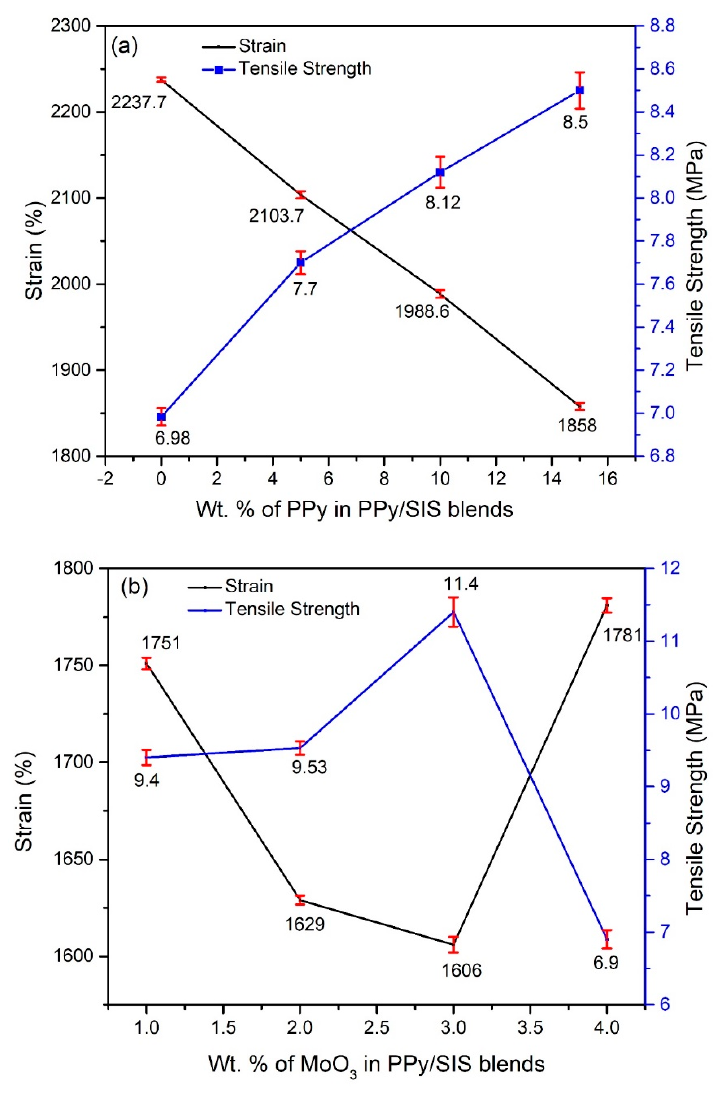
Figure 9. Tensile strength and % strain of various blends: ( a ) 0, 5, 10, and 15 w / w % of PPy / SIS blends; ( b ) 1, 2, 3, and 4 w / w % of MoO 3 / PPy / SIS nanocomposites. Table 2. Mechanical properties of di ff erent w / w % PPy / SIS blends .